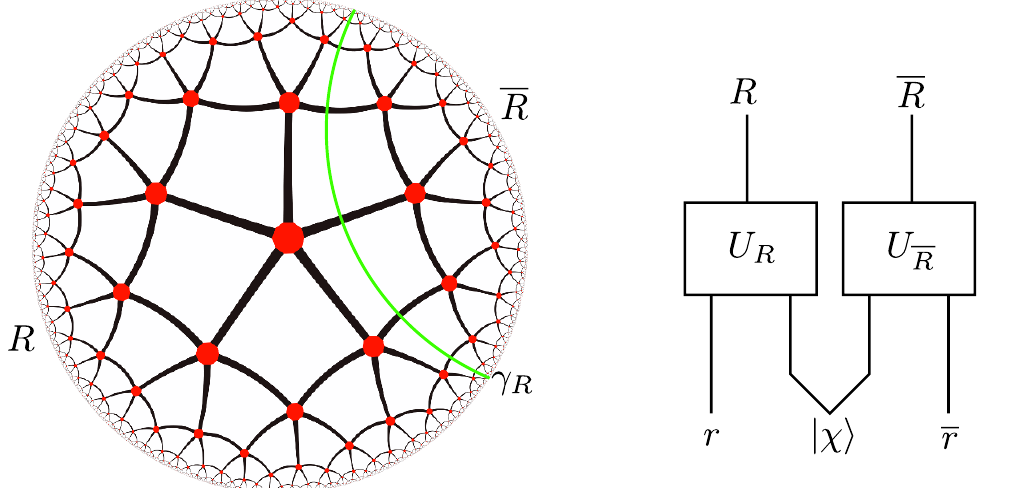
Figure 1 . The encoding circuit for a tensor network holographic code ((cid:12)gure borrowed from [28]). r / r denotes bulk degrees of freedom at the red dots to the left/right of the green HRT surface (cid:13) R , j (cid:31) i is a tensor product of a set of EPR pairs on each link cut by (cid:13) R , and U R / U transformations generated by the pieces of the network to the left/right of (cid:13) R